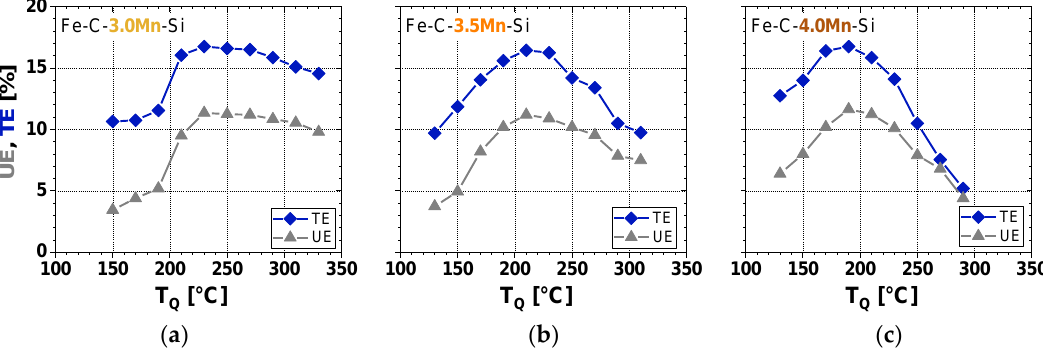
Figure 8. UE and TE as a function of T Q for the ( a ) Fe-C-3.0Mn-Si, ( b ) Fe-C-3.5Mn-Si, and ( c ) Fe-C-4.0Mn-Si steels